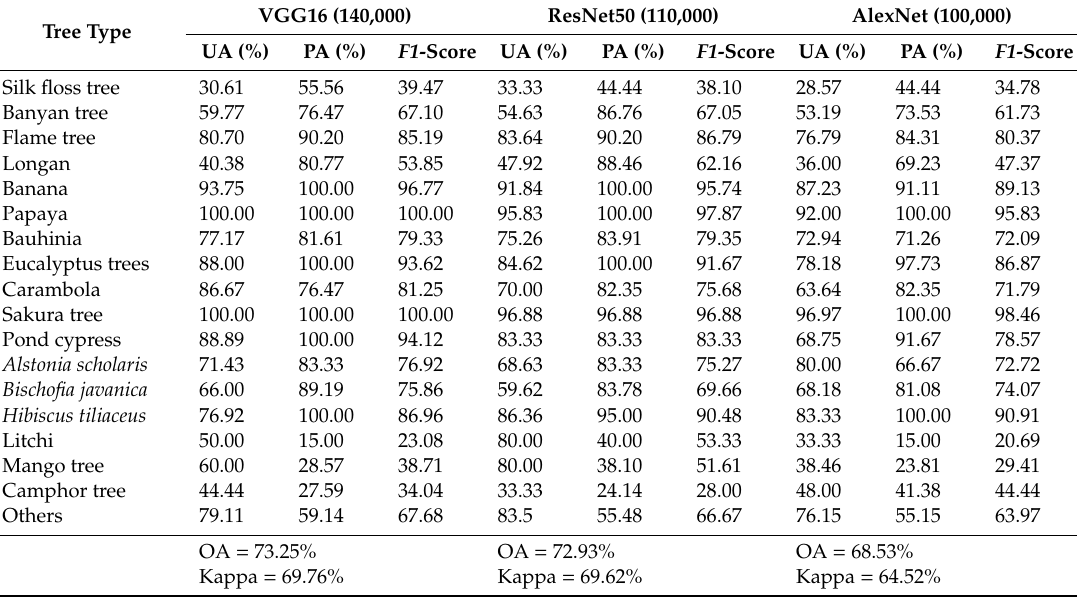
Table 2. Classification accuracies of the three deep learning